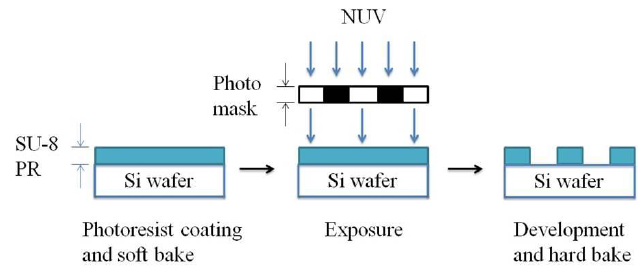
Figure 2. Mold fabrication process by photolithography.